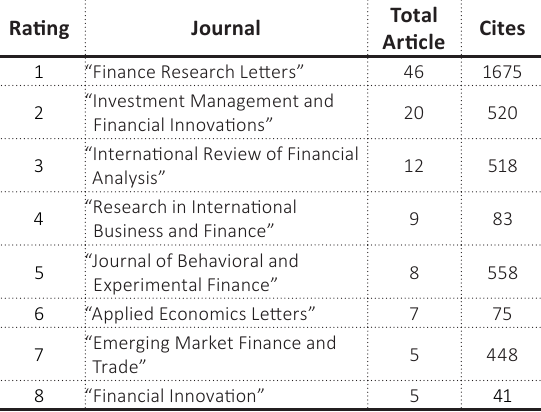
Table 3. The most constructive scientific journals